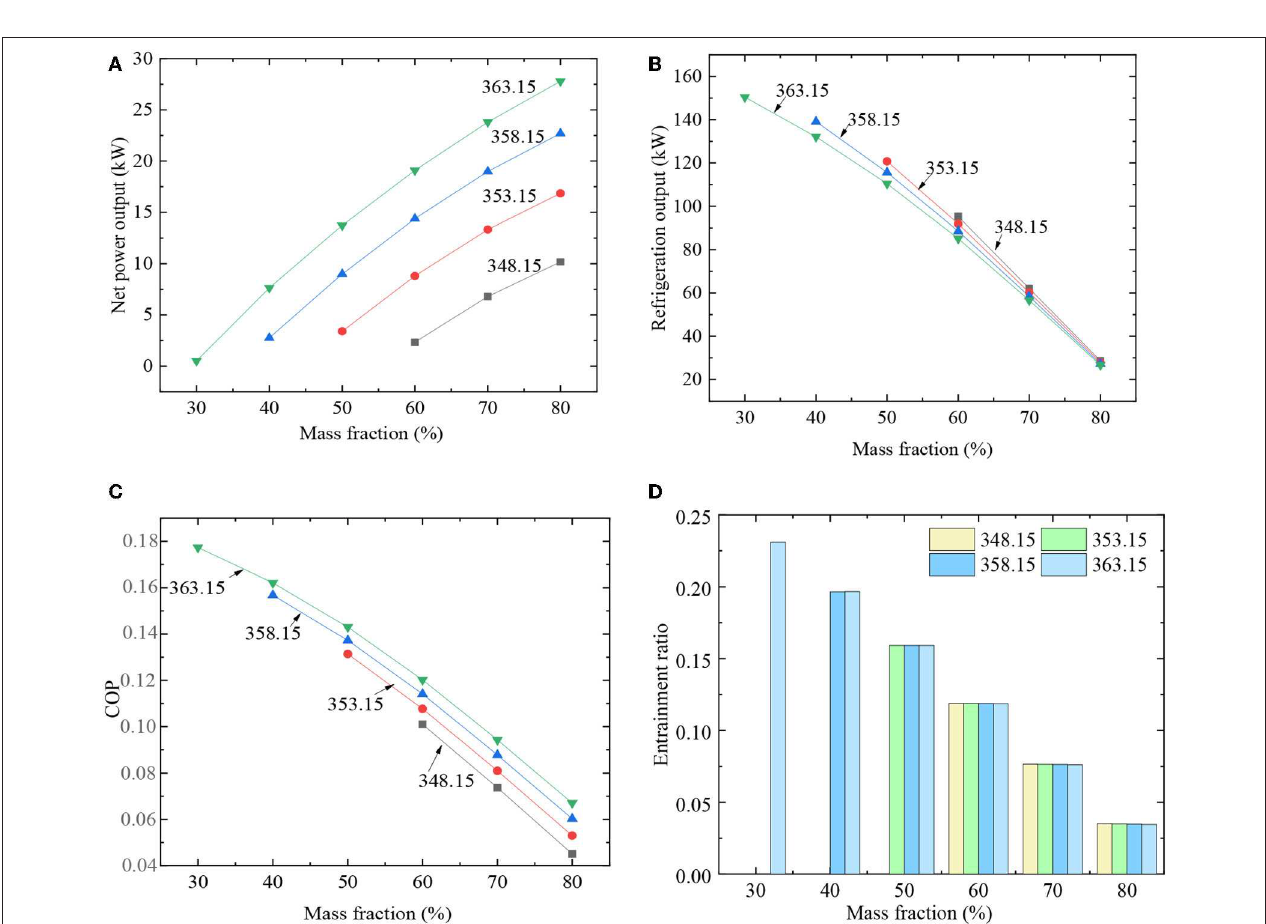
FIGURE 7 | Effect of mass fraction and evaporation temperature. (A) Net power; (B) refrigeration output; (C) COP; (D) entrainment ratio.